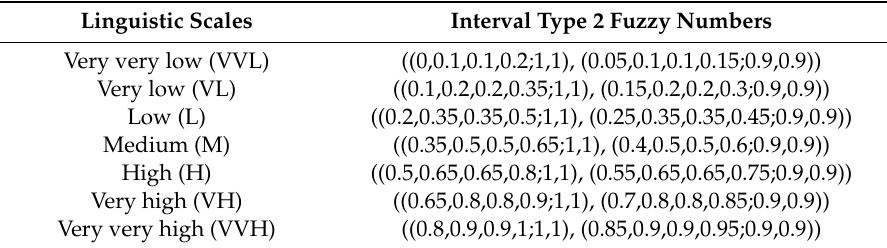
Table 3. Linguistic scales and fuzzy numbers for the criteria and dimensions.